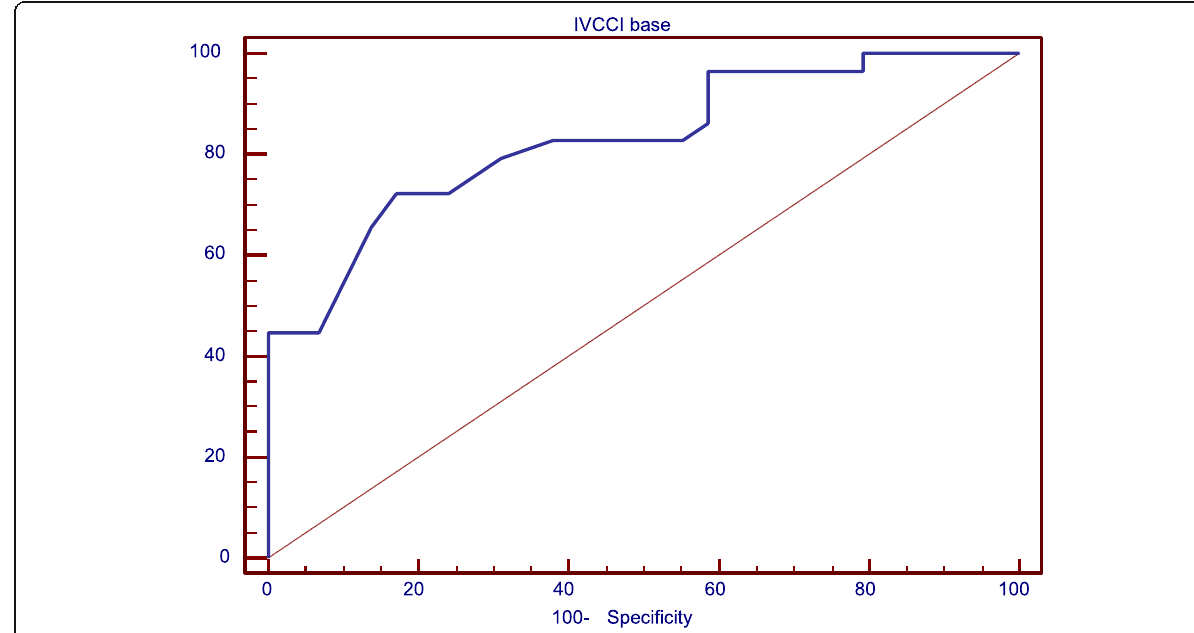
Fig. 1 Receiver operating characteristic (ROC) curve for responders and non-responders as regard baseline IVCCI